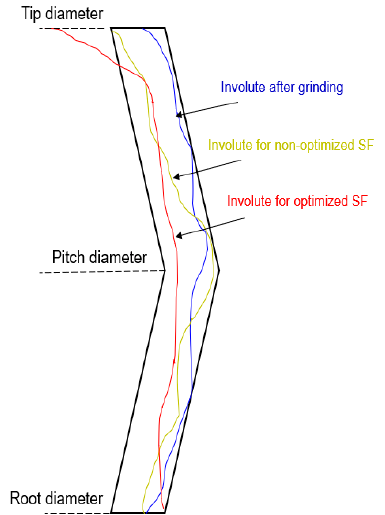
Figure 17. Involute shapes for gears after Stream Finishing process based on typical tolerances from aviation business.